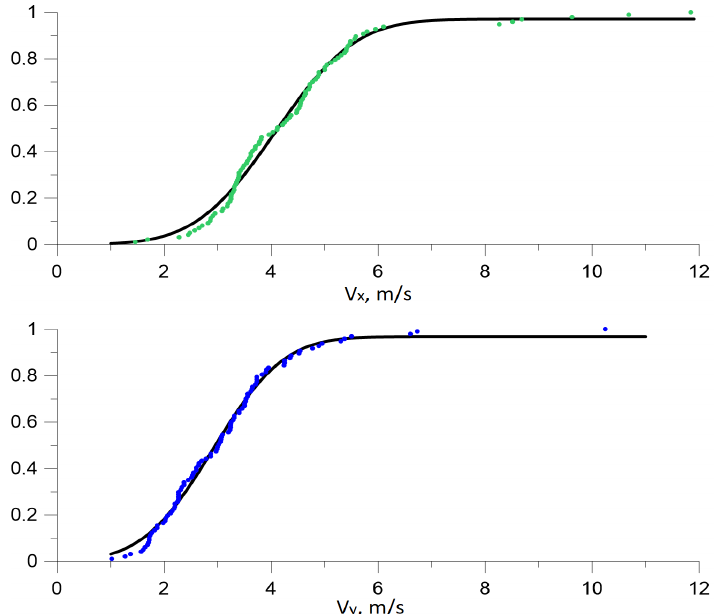
Figure 6. Example of the resulting cumulative distributions for the horizontal (green symbols) and vertical velocity (blue) components and their approximations by Gaussian distribution functions (1). Area of 18.8 mm thickness and position of 35.2 mm.